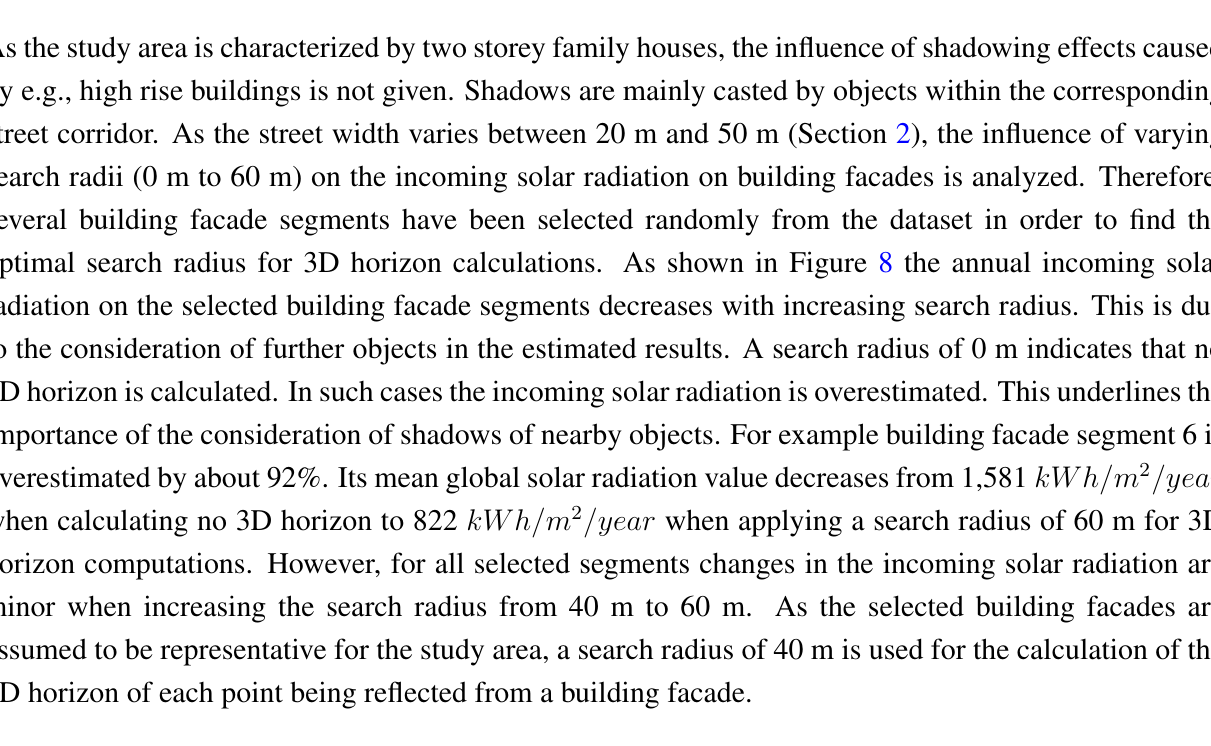
Figure 8. Investigations to find the optimal search radius for the calculation of the 3D